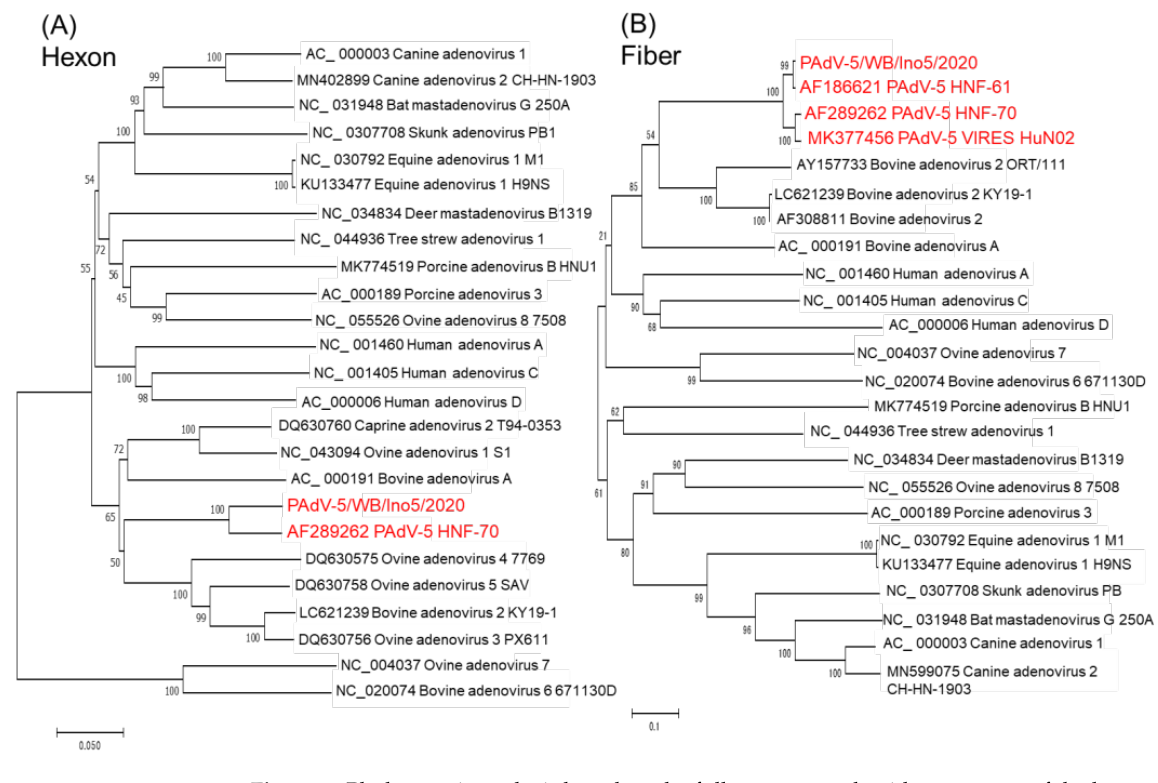
Figure 3. Phylogenetic analysis based on the full genome nucleotide sequences of the hexon ( A ) and fiber ( B ) coding region of PAdV-5s and other adenoviruses. The trees were constructed according to the neighbor-joining method in MEGA7 with 1000 bootstrap values. The bar represents a corrected genetic distance. PAdV-5 strains are colored in